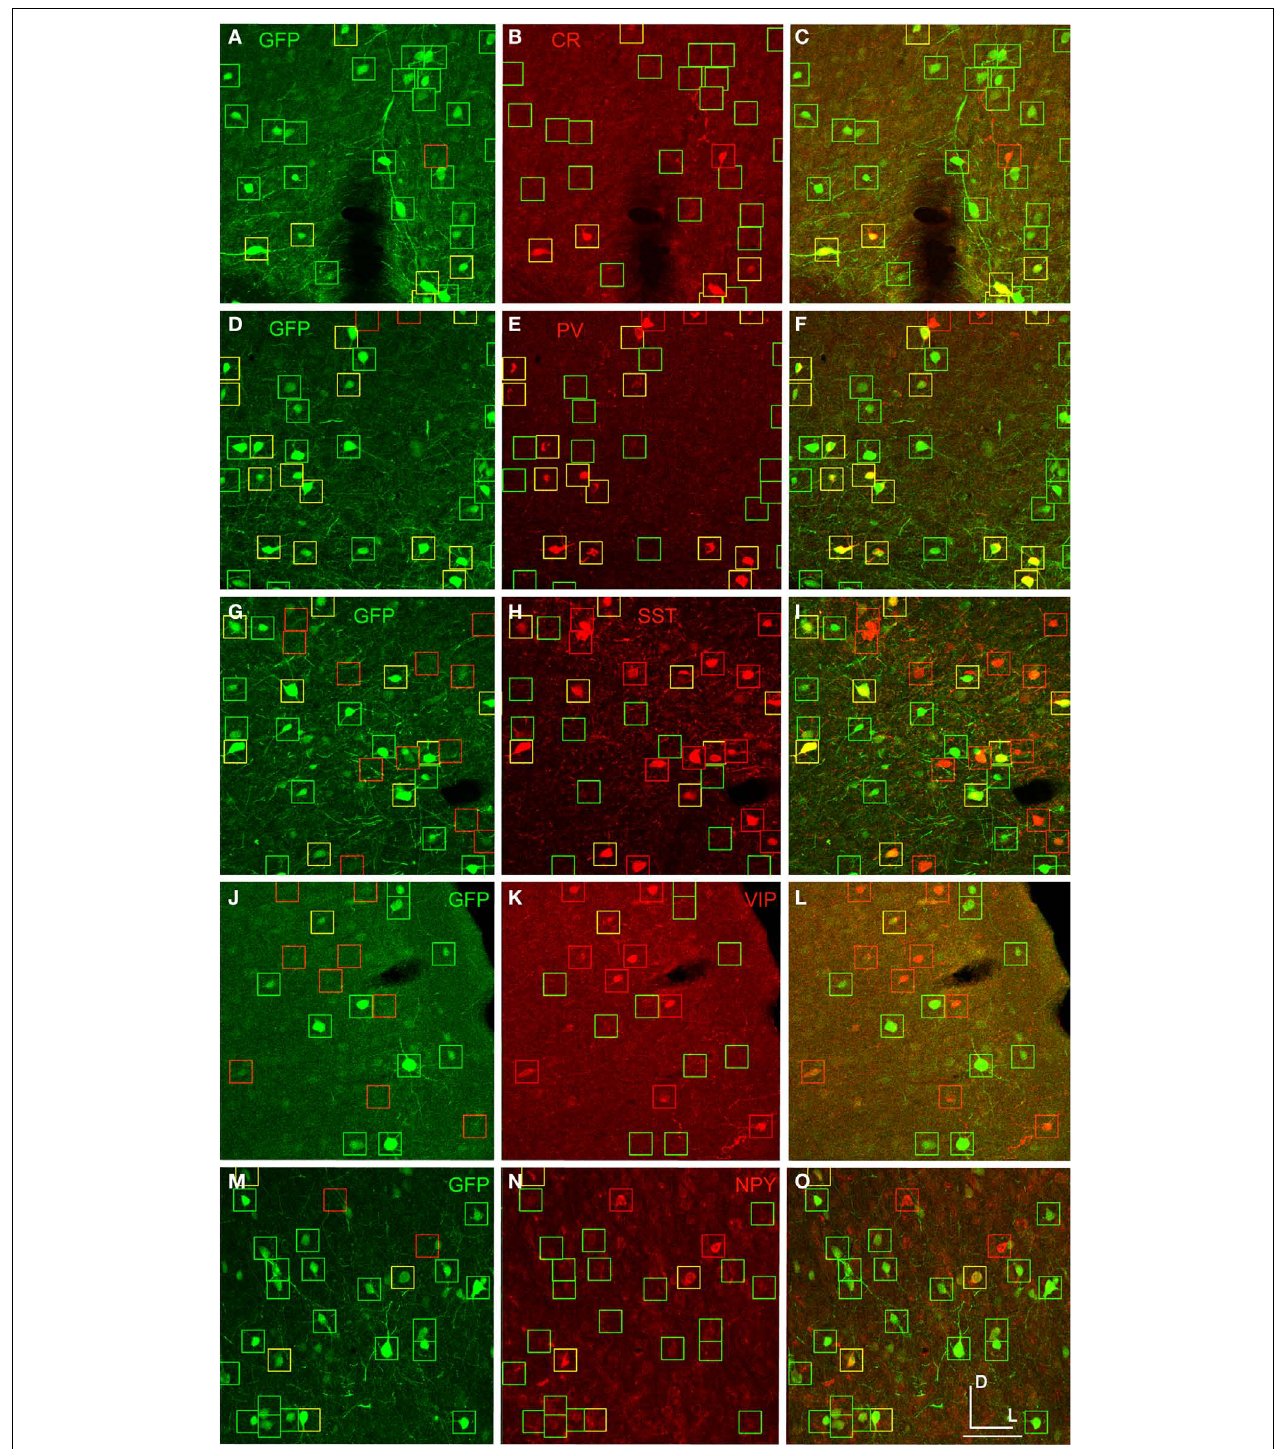
FIGURE 7 | AAV-fSST expression co-labeled with CR, PV, SST, VIP and NPY antibodies. AAV-fSST-GFP expression in mouse somatosensory cortex is shown in the left column (A,D,G,J,M). Cell-type specifi c antibody labeling in the corresponding sections are shown in the middle column (B,E,H,K,N). Overlaps of the left and middle columns are shown in the right column – (C,F,I,L,O) – calretinin [CR – (B,C) ], parvalbumin [PV – (E,F) ], somatostatin